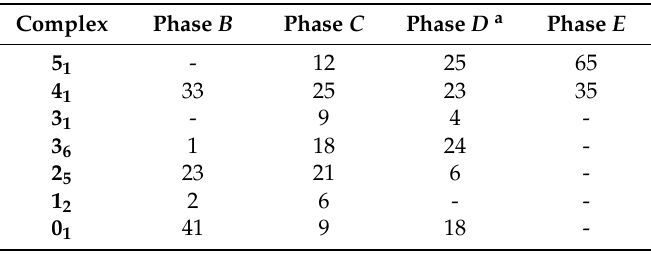
Table 3. The composition of solid solutions B – E based on the observed disorder in the crystal structures (see Supporting